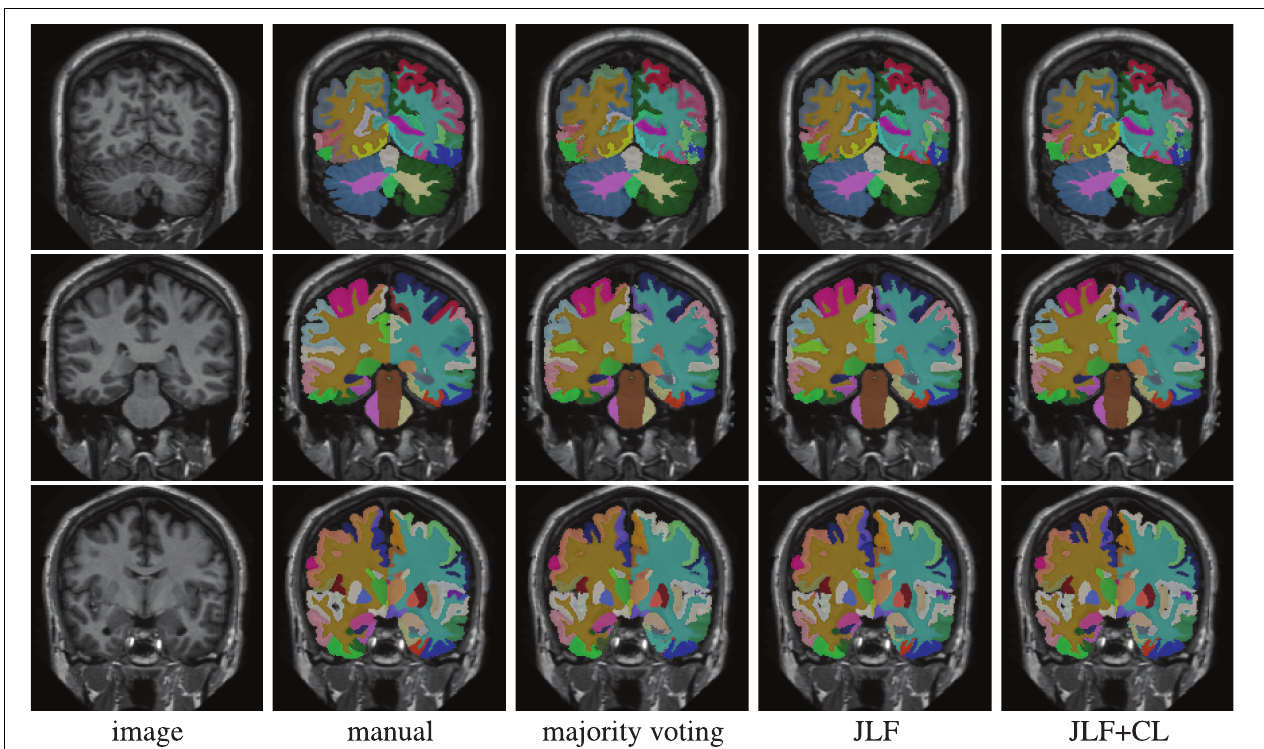
for subcortical labels. Corrective learning improved the results to 0.771, 0.747, and 0.836,